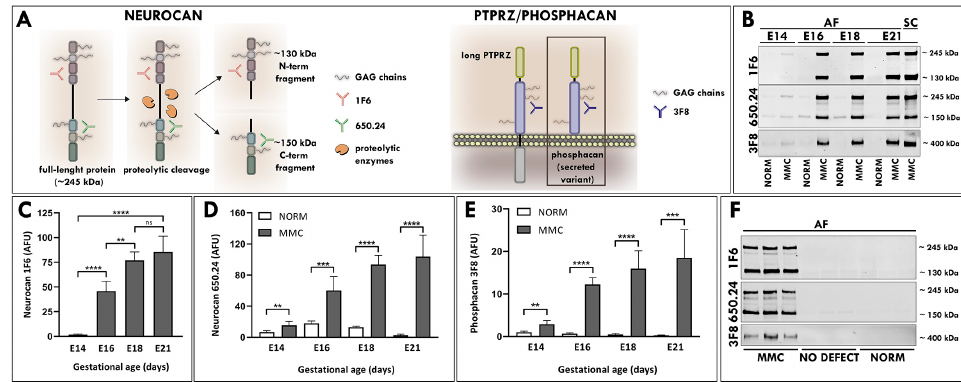
Figure 2. ( A ) Schematic representation of the domain organization of neurocan and its major pro- teolytic fragments, N-terminal fragment, and C-terminal fragment, as well as a long splice form of PTPRZ and its extracellular variant, phosphacan. Domains recognized by 1F6 and 650.24 and 3F8 antibodies are indicated. ( B ) Equal volumes of AF samples pooled from three randomly selected MMC fetuses or age-matched normal fetuses collected at E14, E16, E18, and E21 were digested with ChABC, loaded on the gel, and subjected to Western blotting analyses. A representative Western blot with 1F6 and 650.24 antibodies illustrates detection of full-length neurocan and the N-terminal fragment (245 kDa and 130 kDa) in the AF of MMC fetuses at all embryonic ages and full-length neurocan and the C-terminal fragment (245 kDa and 150 kDa). Analogous Western blotting analysis with the 3F8 antibody demonstrates detection of phosphacan (~400 kDa) in the AF of MMC fetuses at all embryonic ages. In the SC lane, MMC spinal cord lysates were loaded on the gel as positive controls. ( C – E ) Quantitative analyses of total neurocan and phosphacan proteins in the AF of MMC fetuses and the AF of age-matched normal controls. Graphs represent the change in arbitrary fluo- rescence units (AFU) at each time point. Data are presented as mean ± SD of 15 randomly selected AF samples per group., ** p < 0.01, *** p < 0.001, **** p < 0.0001. ( F ) Equal volumes of AF samples from randomly selected individual fetuses collected at E21 were digested with ChABC loaded on the gel and subjected to Western blotting analyses with 1F6, 650.24, and 3F8 antibodies. Representa- tive Western blot illustrates detection of neurocan and phosphacan in all AF samples from individ- ual E21 fetuses with MMC defect but very weak or no neurocan and phosphacan detection in litter- mates with no MMC defect after RA exposure and normal controls. Data represent six AF samples per group.